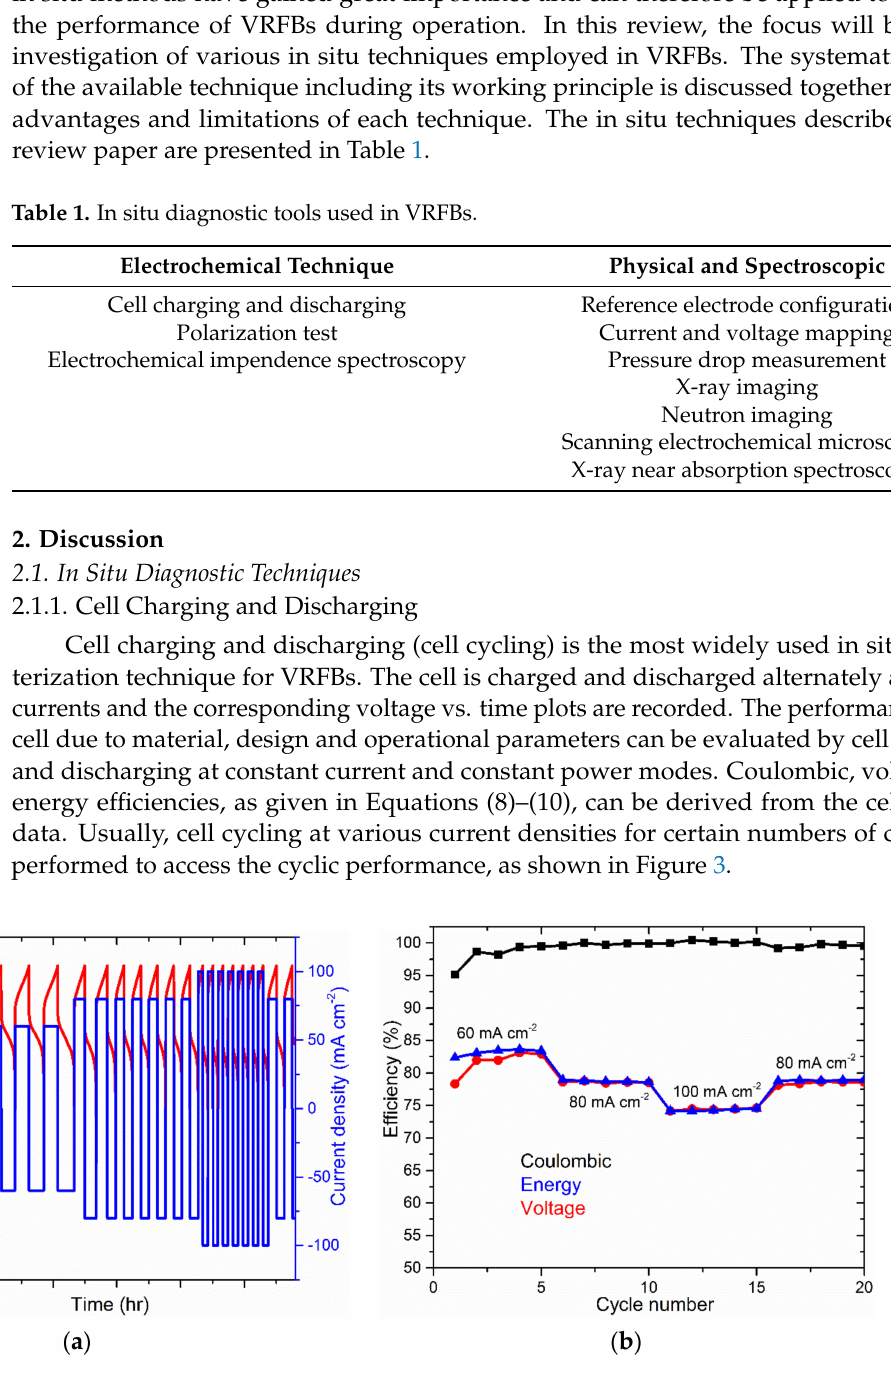
Figure 3. ( a ) Typical charge-discharge cycles curve at various current densities and ( b ) Coulombic, energy and voltage efficiency corresponding to charge-discharge